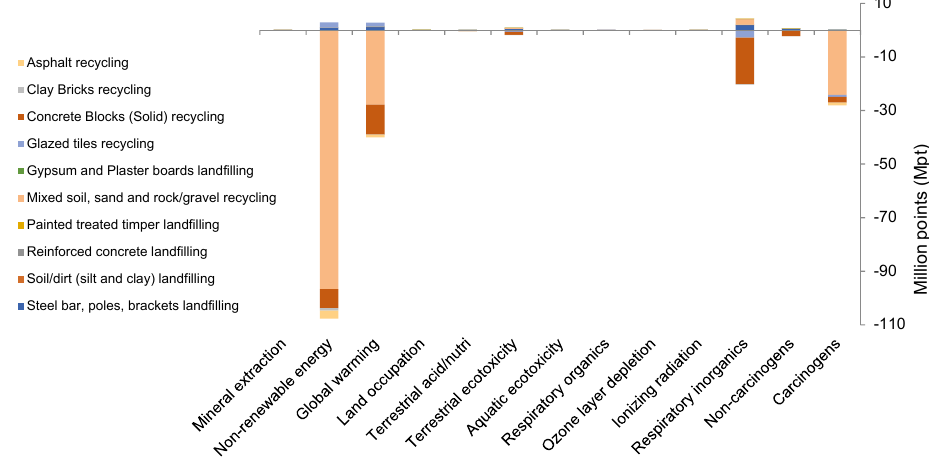
Figure 5. Normalized results of impact assessment of the BCS of construction and demolition waste management system in Riyadh City obtained by using normalized factors for Europe of Impact 2002+ methodology. The vertical axis shows the percentage increase or decrease in life cycle impact categories due to recycling of the particular type of CDW, in comparison to the case of its direct disposal.